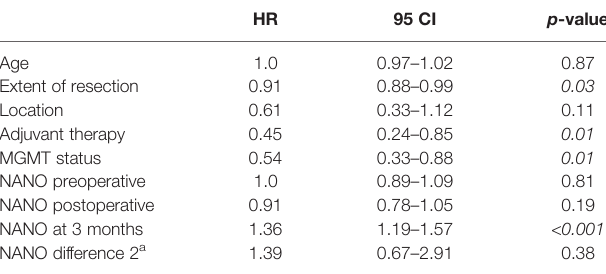
TABLE 2 | Multivariate Cox regression.